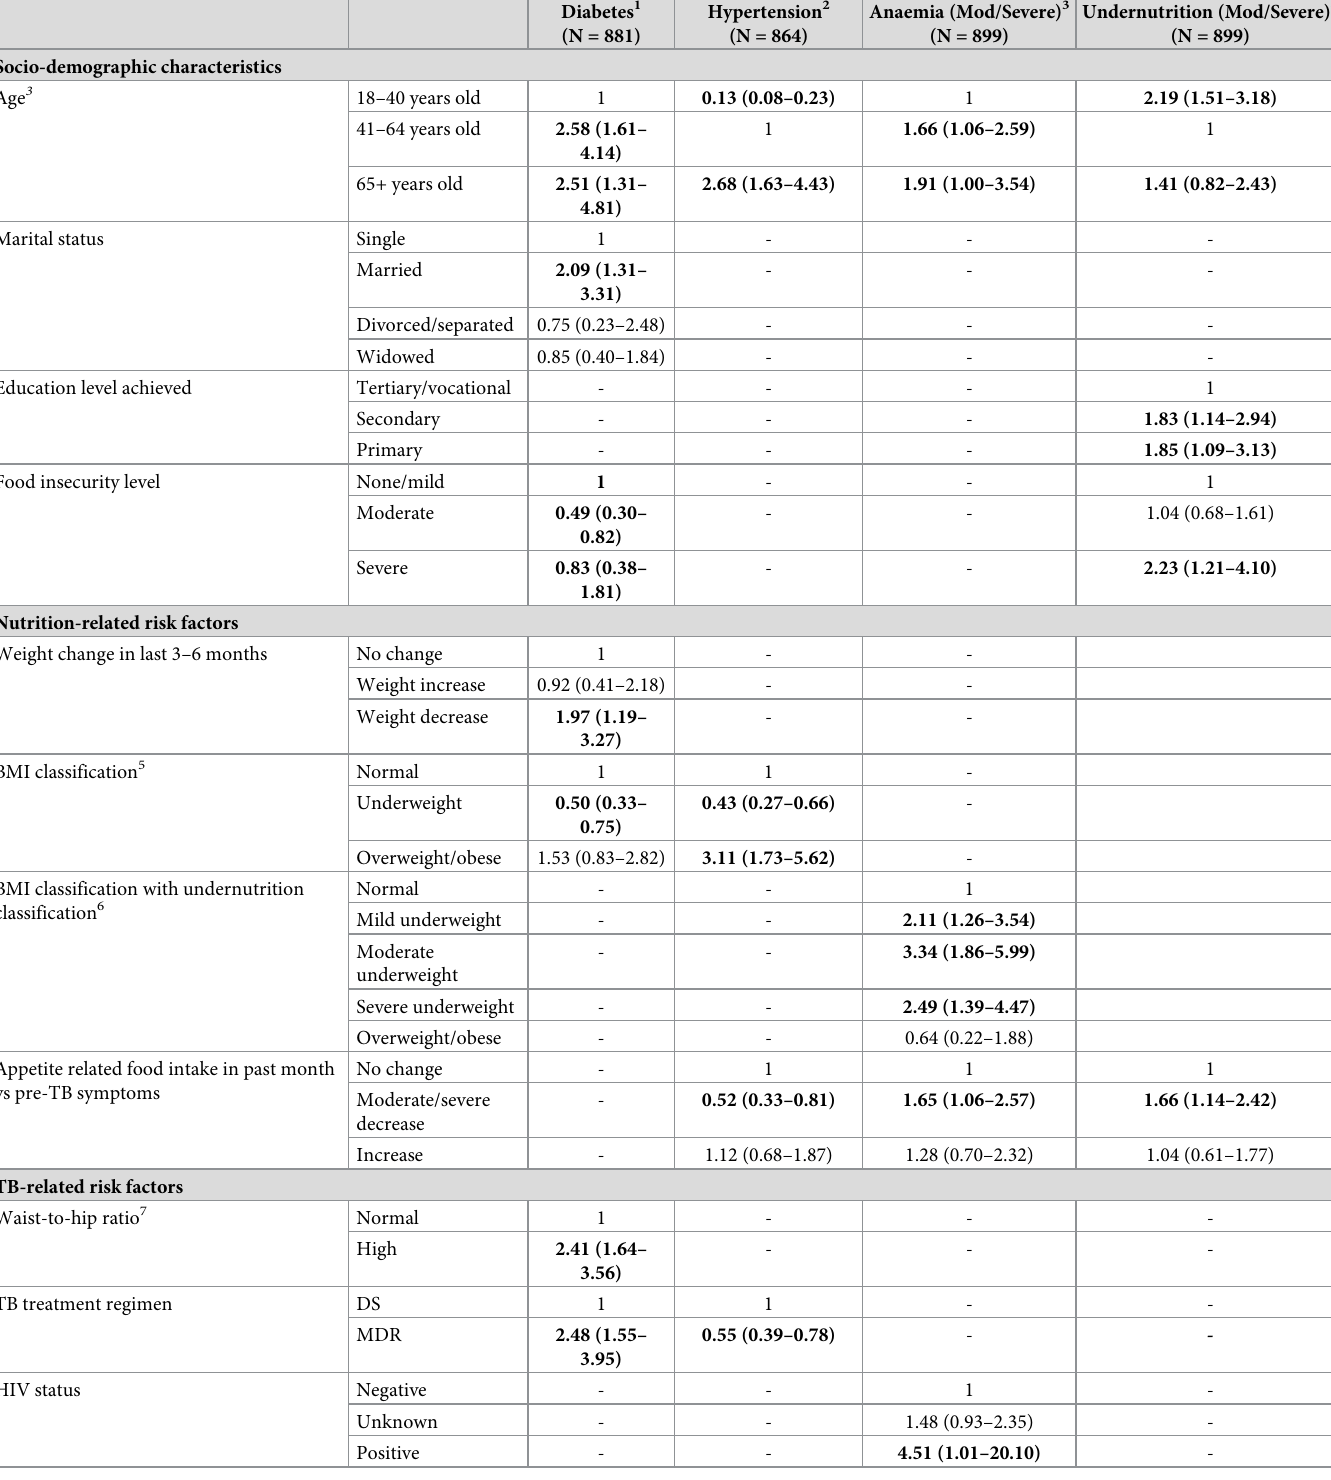
Table 2. Multivariable odds ratios (95% confidence intervals) for factors associated with each